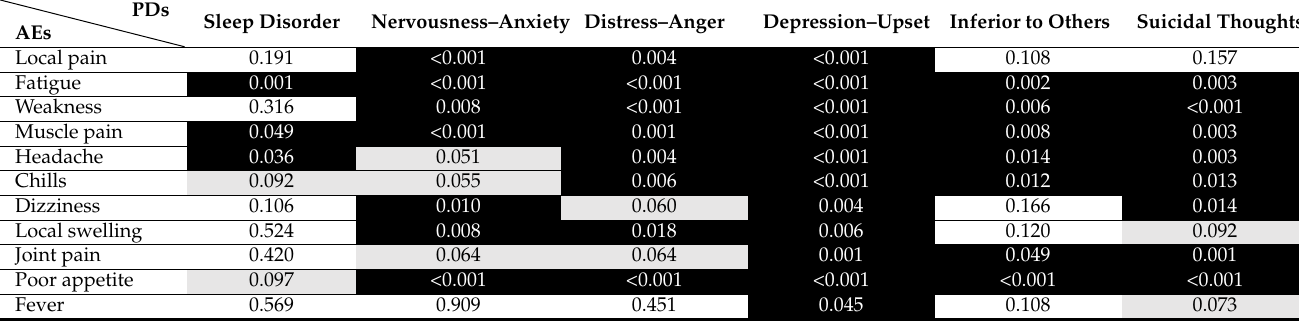
Table 2. Generalized estimating equations for psychological disorders (PDs) and adverse events (AEs).